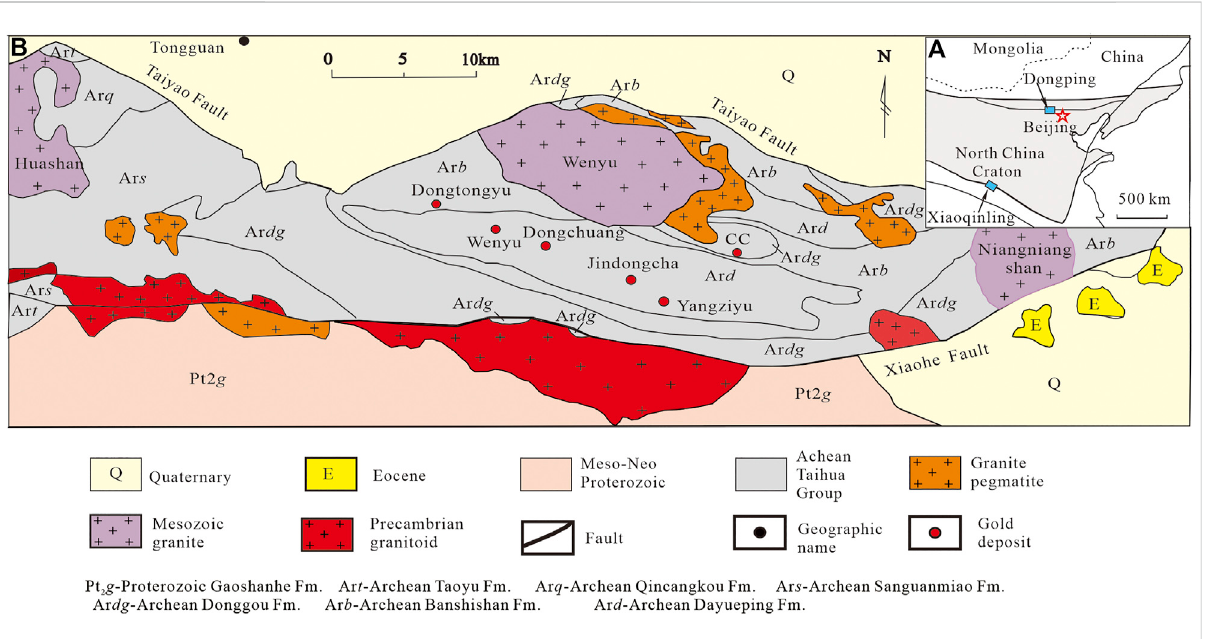
FIGURE 1 Geologicalsketch mapoftheresearcharea; (A) -Tectonicsubdivisions ofNorthChina Craton, showingthelocationofXiaoqinlinggolddistricts (modi fi edafterHart etal.,2002;ZhouandWang,2012); (B) -Geological sketchmapoftheareaaroundtheXiaoqinling golddistrict(modi fi edafterXu et al., 1998; Jiang et al.,